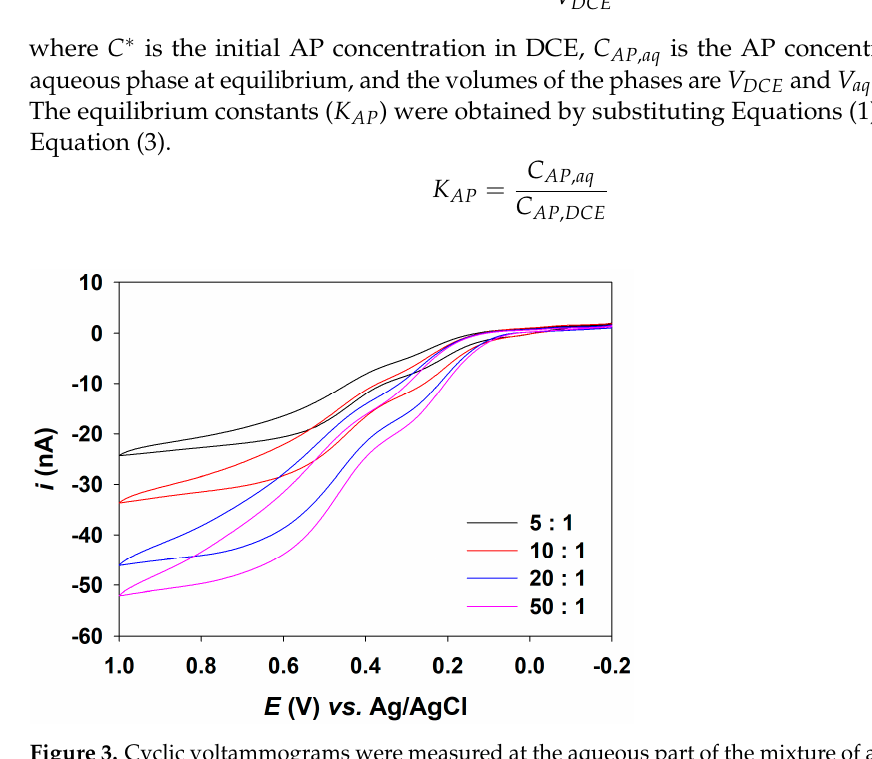
Figure 3. Cyclic voltammograms were measured at the aqueous part of the mixture of a DCE solution containing 1 mM AP and an aqueous solution containing 100 mM MgSO 4 solution with various volume ratios (5:1, 10:1, 20:1, and 50:1, respectively), using a 25 µ m Pt-UME at a scan rate of 100 mV/s.